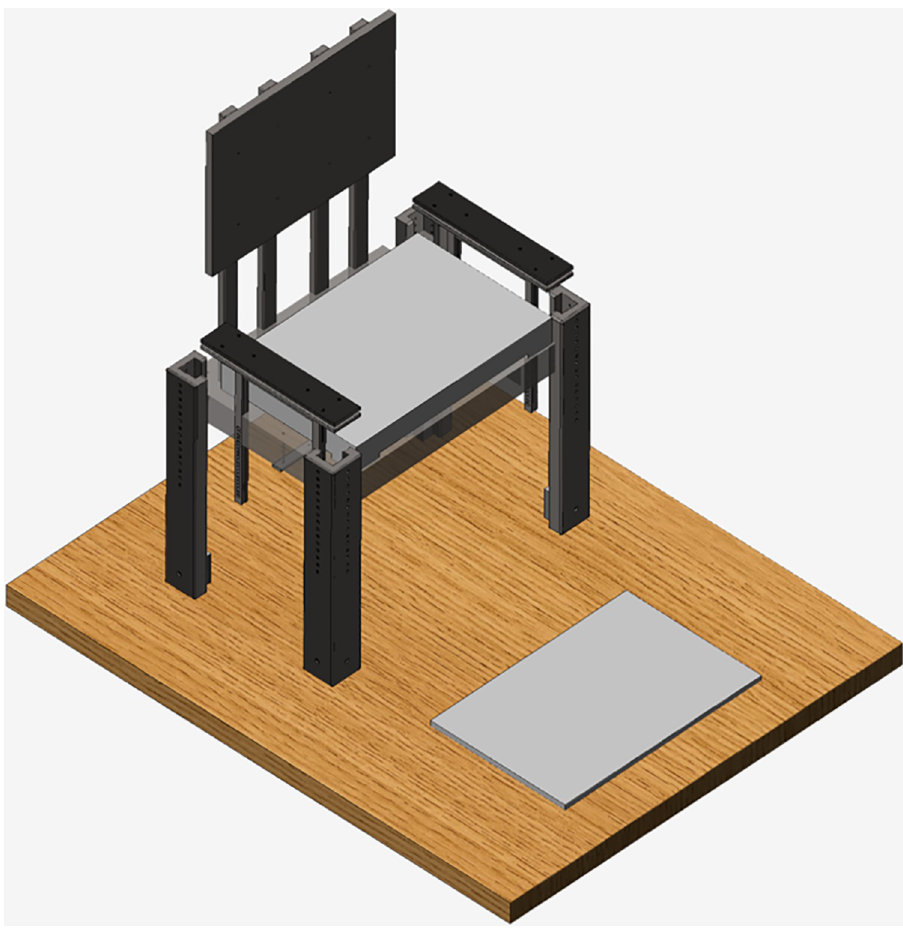
Fig 1. A 3-dimensional render of the BENCH